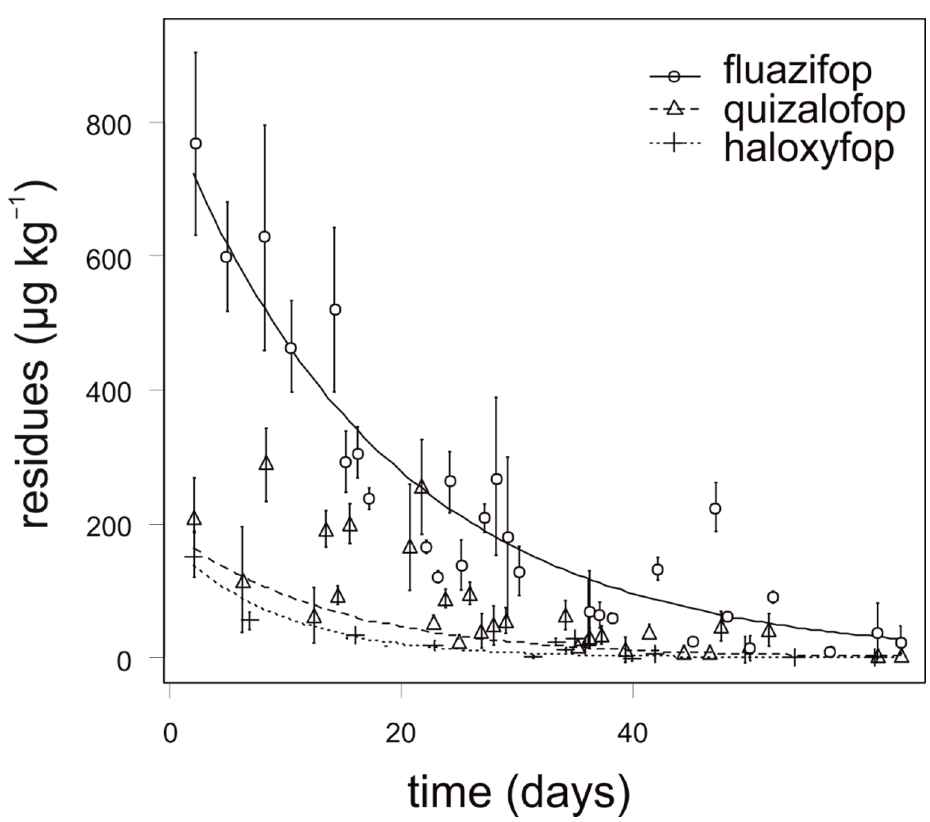
Figure 1. Degradation dynamics of fluazifop, quizalofop, and haloxyfop in carrot. Mean values with error bars representing standard error of the mean. Table 7. Active pre-harvest interval for tested herbicides in tested vegetables for current MRL.